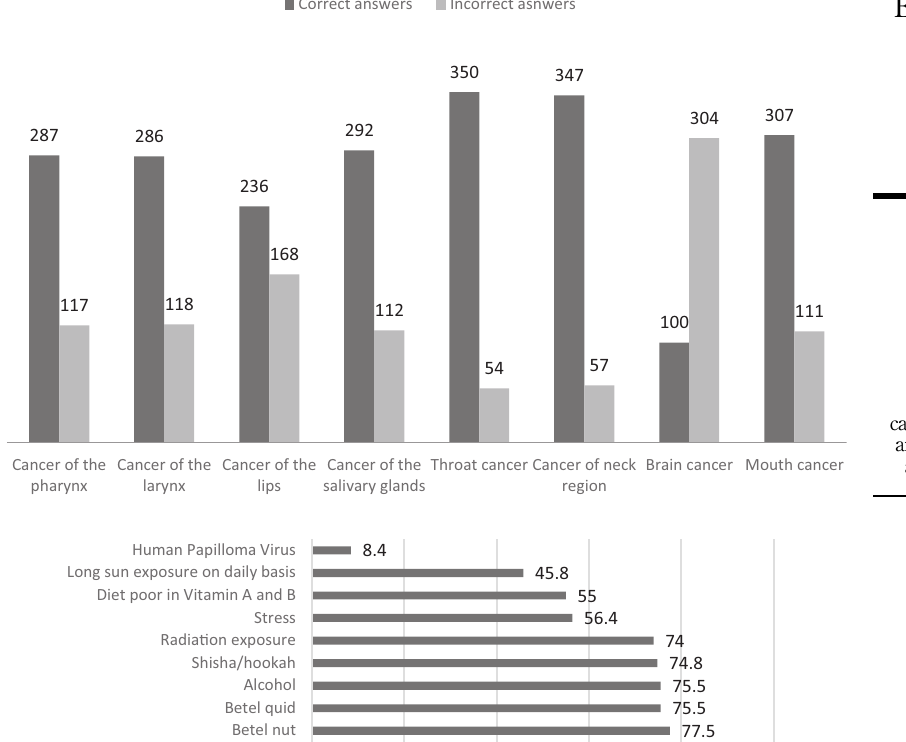
Figure 2. Percentage of identification of risk factors of head and neck cancer